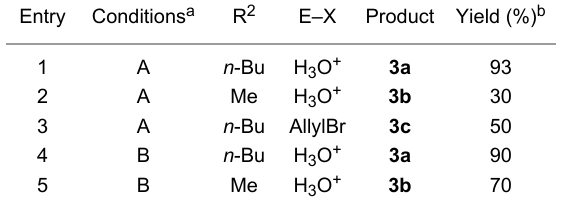
Table 1: Carbometallation reactions of the N -alkynylsulfonamide 2 .